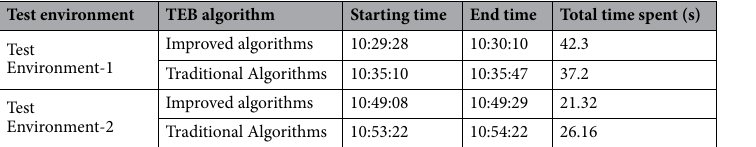
Table 5. Time comparison before and after improving the TEB